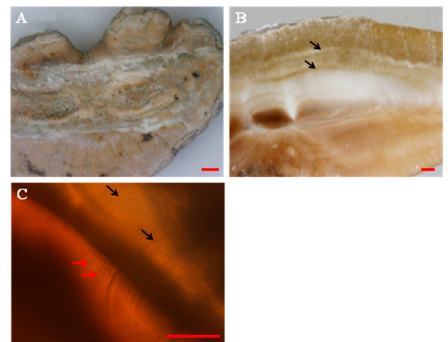
Figure 5 . Micrograph of Ventrifossa sp. The narrower incremental lines ( C , red arrow) were observed, as well as the long-period incremental lines ( B , C , average 78 μ m: black arrows). Digital microscopy images ( A : otolith surface, B : cross-sectional image). Ground specimen of polarizing micrograph ( C ). Scale bar: 500 μ m ( A ), 100 μ m ( B ), 50 μ m ( C ).